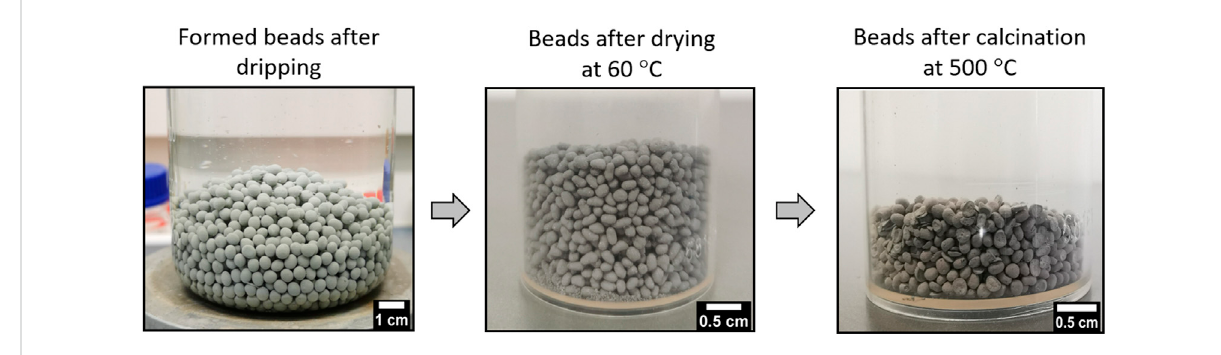
FIGURE 1 Pictures of the obtained beads calcined at 500 ° C at each step of the